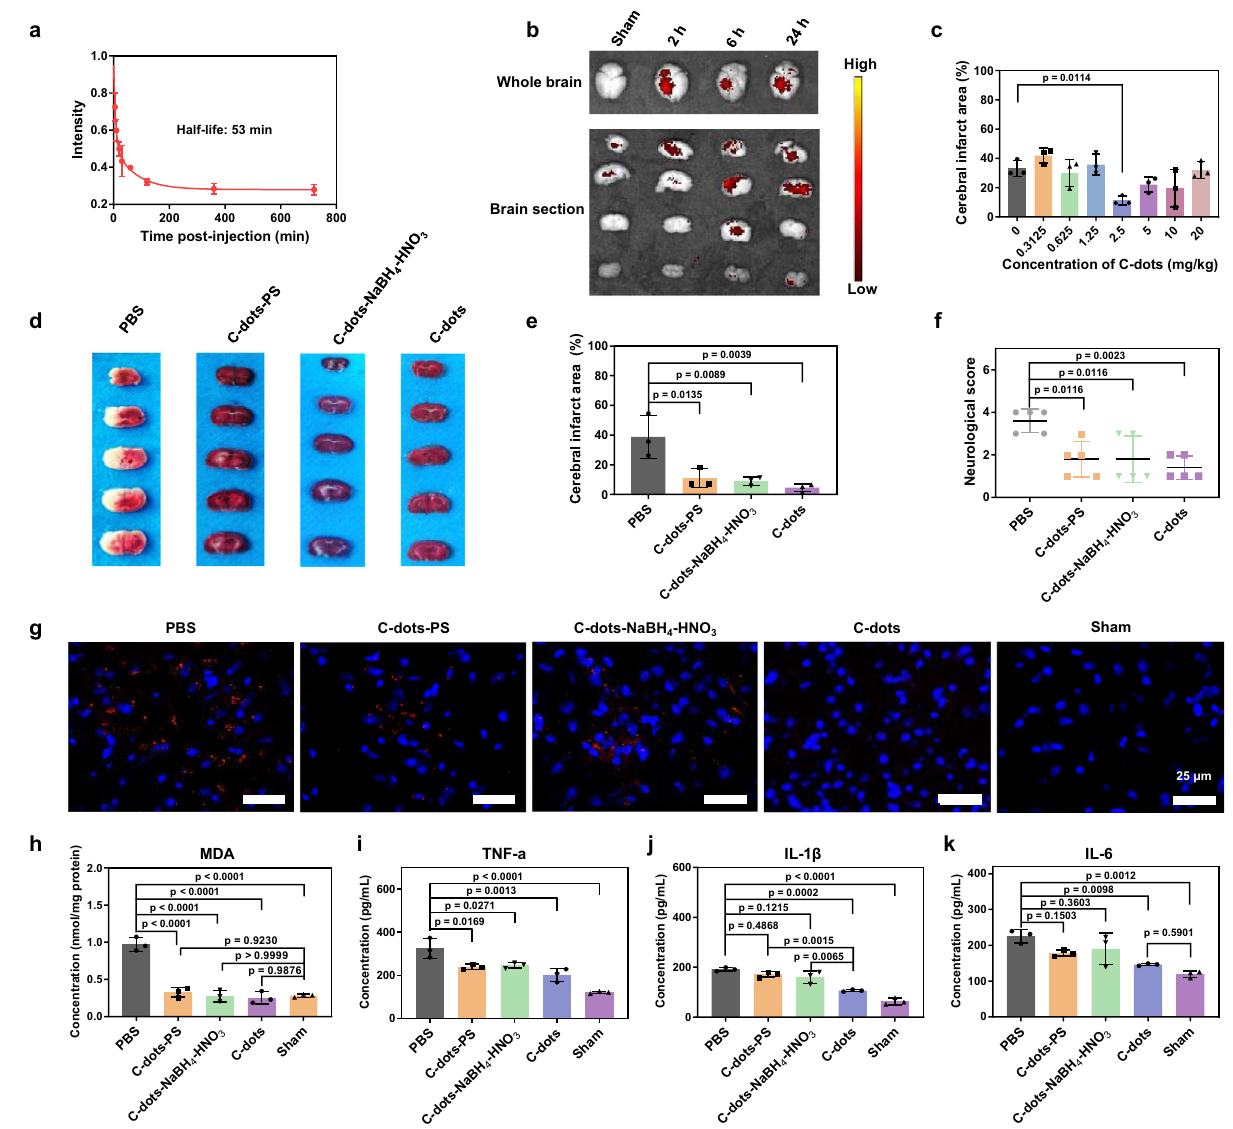
Fig. 6 | Brain protection of C-dot SOD nanozymes against middle cerebral artery occlusion (MCAO)-induced ischemic and reperfusion injury. a Half-life analysis of C-dot SOD nanozymes in plasma ( n =3 mice). b Ex vivo fl uorescence imaging analyses of the accumulations of C-dot SOD nanozymes (labeled with Cy5.5)inthebrainsofsham(24hpost-injection)andMCAOmice(2h,6h,and24h post-injection), and corresponding brain sections ( n =3 mice). c The cerebral infarcted area analysesof MCAO mice treated with different dosages ofC-dotSOD nanozymes for 24h ( n =3 mice). d Representative 2,3,5- triphenyltetrazolium chloride-stained brain sections and ( e ) quanti fi cation of cerebral infarct areas of